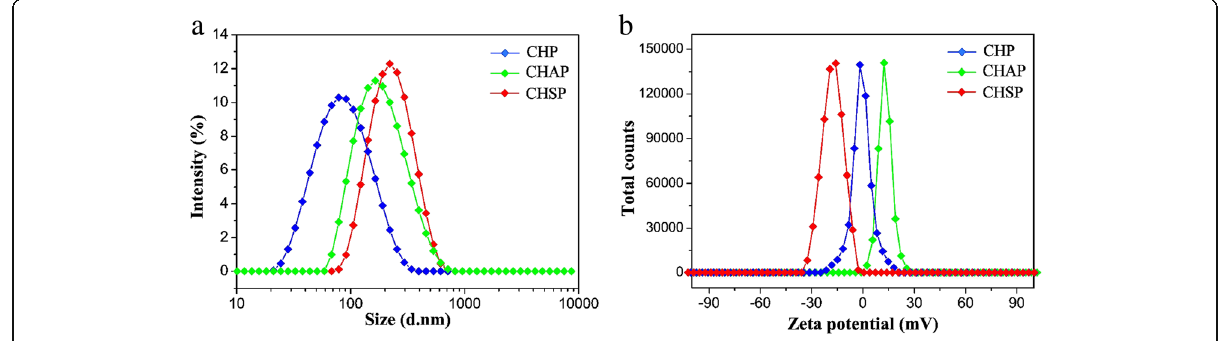
Fig. 4 Zeta potential ( a ) and size distribution ( b ) of CHP NPs ( ), CHAP NPs ( ), and CHSP NPs ( )